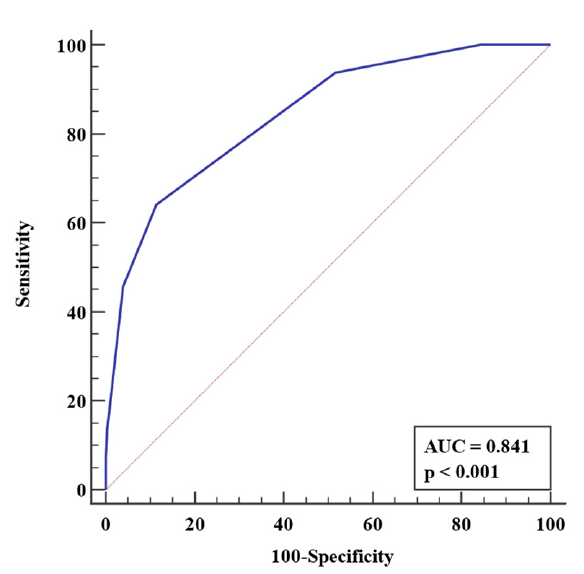
Figure 3. Receiver operating curve of scoring index in predicting pulmonary complications. Table 7. Diagnostic values at different cut-off score.